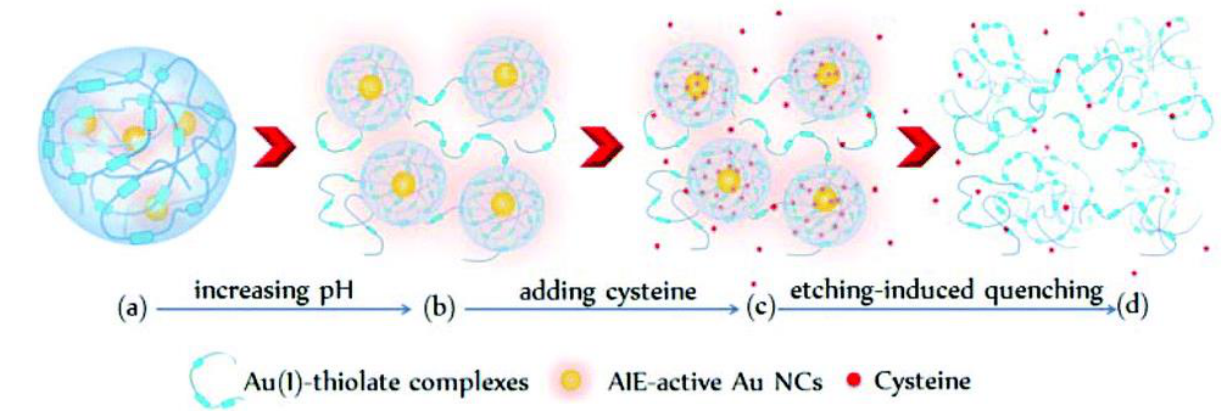
Figure 10. Schematic illustration of cysteine-induced etching and luminescence quenching of AIE-Au NCs. ( a ) the AIE-active Au NCs encapsulated by the Au(I)-thiolate complex network; ( a → b ) Increasing the pH prompted the disassembly of the Au(I)–thiolate complex network; ( b → c ) alkaline pH allowed cysteine to enter the Au NCs; ( c → d ) cysteine molecules etched the Au(0) cores. Reprinted with permission from Ref. [46]. Copyright © 2019 RSC Pub.